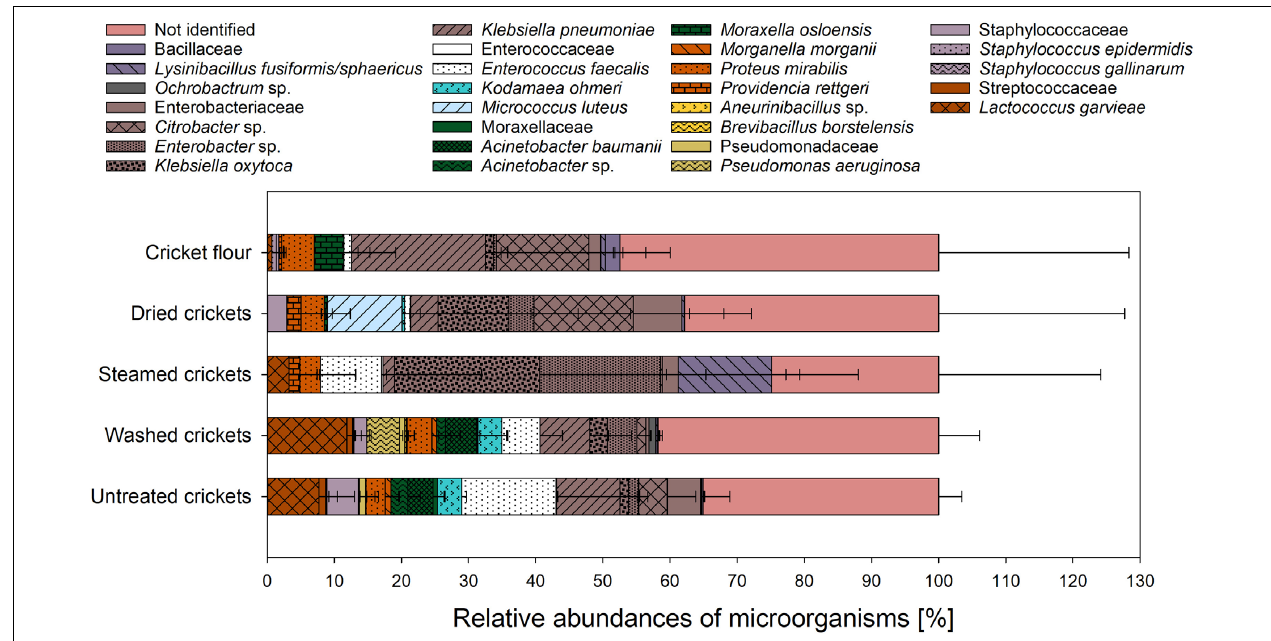
FIGURE 4 | Relative abundances of analyzed microorganisms from process water along the processing chain of cricket